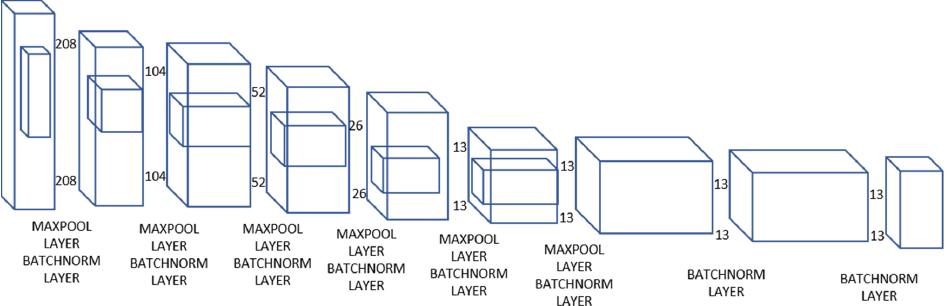
Figure 3. Tiny-YOLO (you-only-look-once)-v2 Architecture.